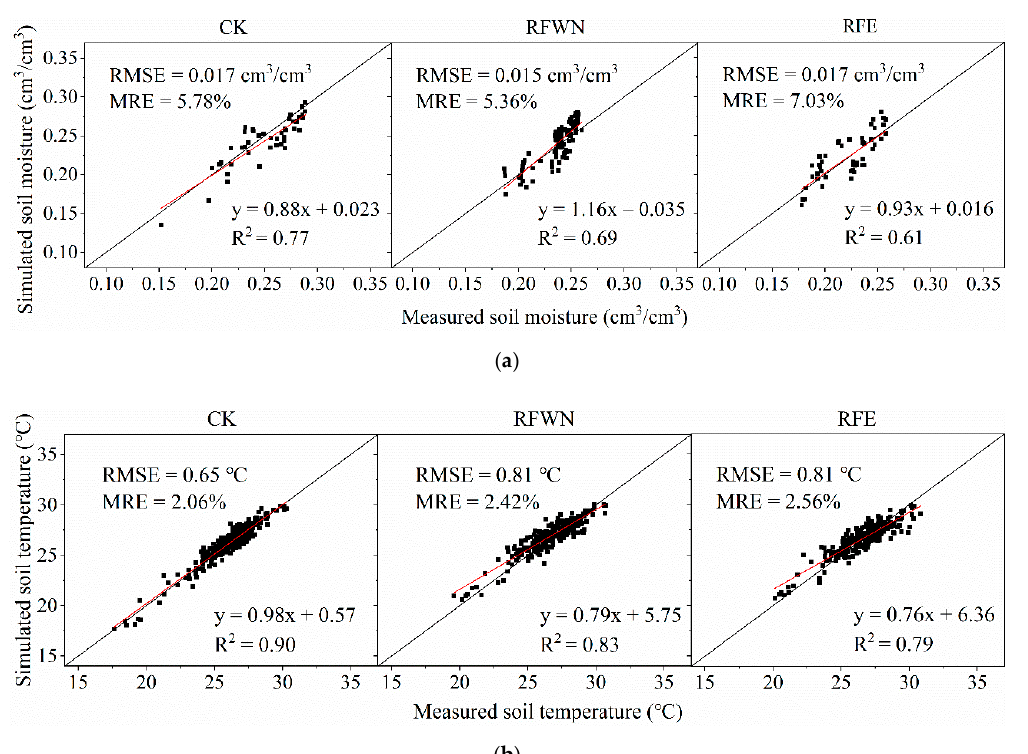
Figure 3. Calibration results of soil moisture and temperature based on HYDRUS - 2D model in 2019. ( a ) Calibration results of soil moisture; ( b ) Calibration results of soil temperature.